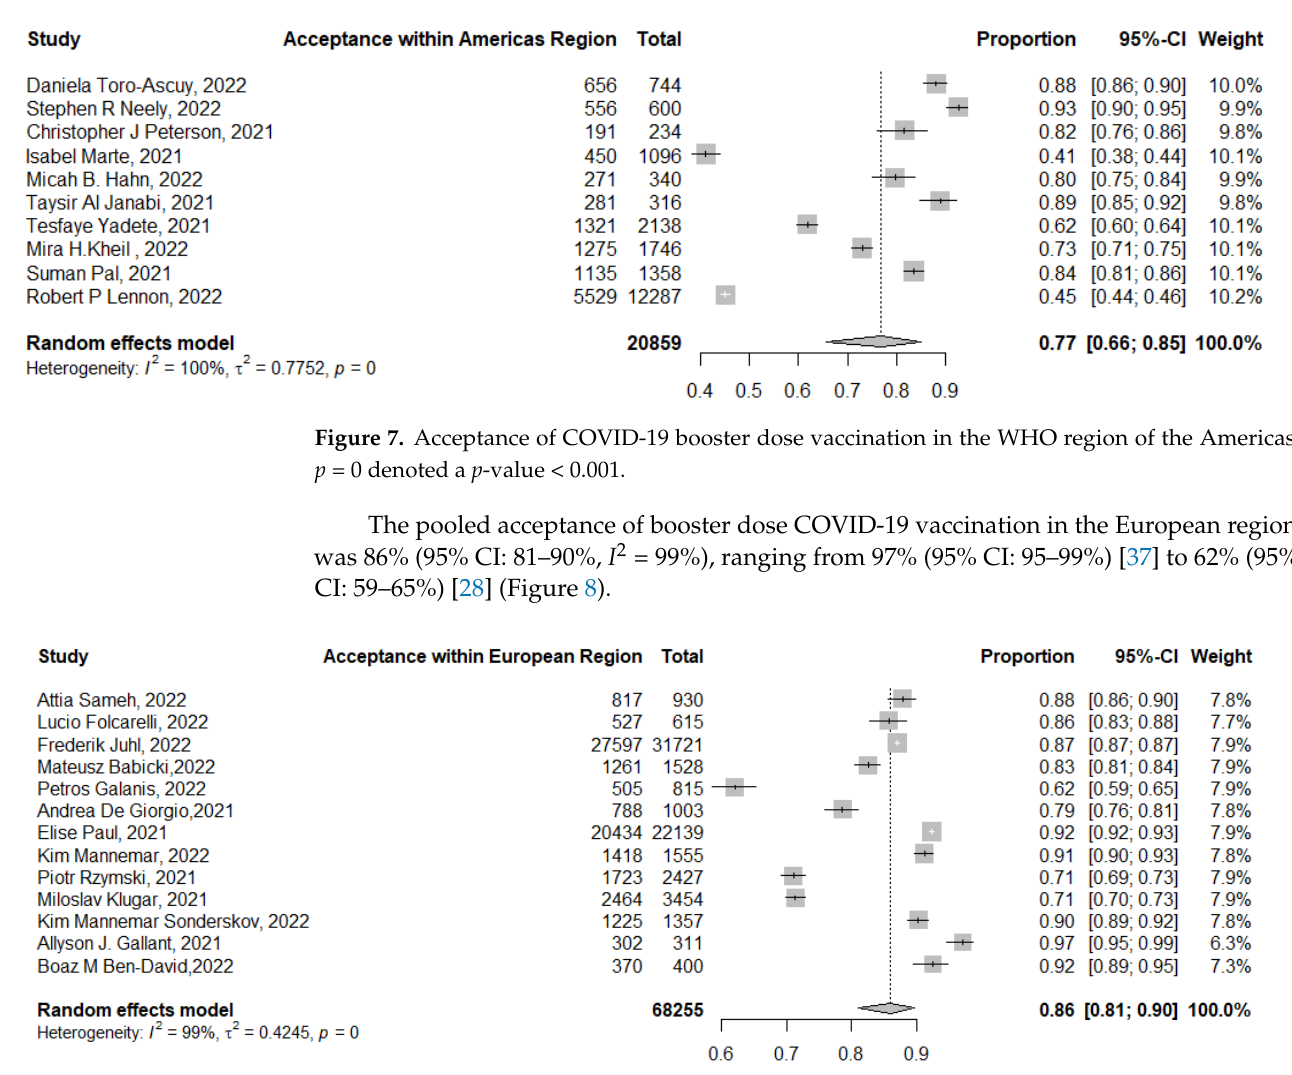
Figure 8. Acceptance of COVID-19 booster dose vaccination in the WHO region of Europe. p = 0 denoted a p -value < 0.001.